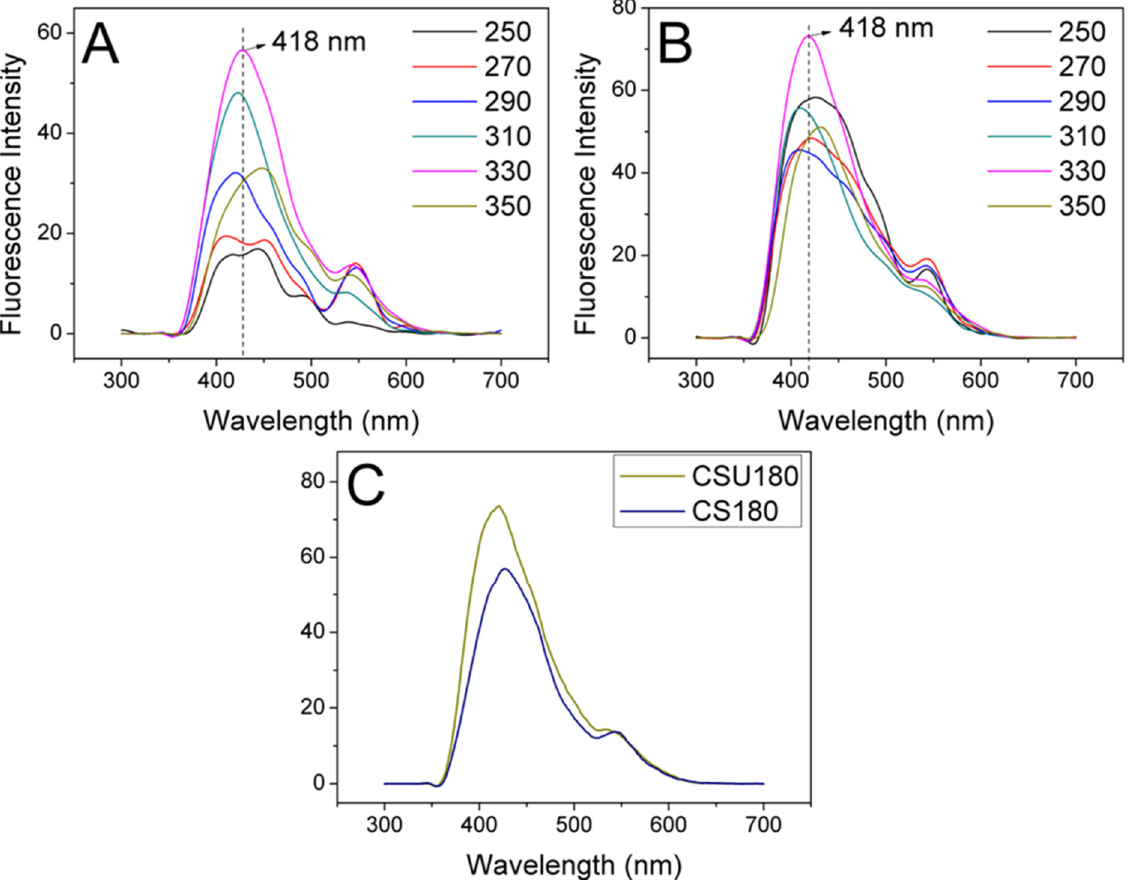
Figure 7. Fluorescence spectra of CS180 ( A ), CSU180 ( B ) and their combination at 418 nm ( C ).